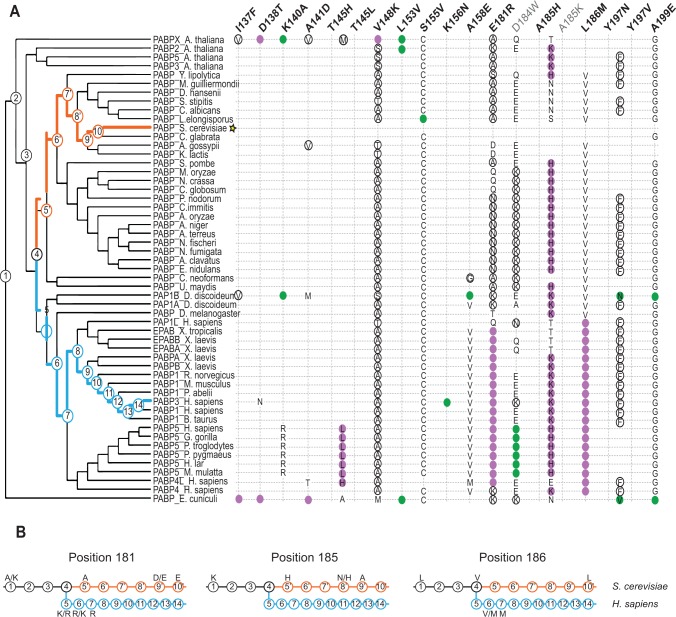
Distribution of single amino acid substitution effects across the Pab1 phylogenetic tree.A) A cladogram describing the phylogenetic lineage of 52 Pab1 homologues. The numbered nodes along the tree represent the common ancestors shared between different branches of the tree that lead to the speciation of PABP-1 orthologues in S. cerevisiae and H. sapiens. The light blue and the orange paths represent the evolutionary lineages of the human and the yeast, respectively, since the fungal and metazoan poly(A)-binding protein divergence. The position of S. cerevisiae in the tree is designated by a star. Each column represents one of the 19 single amino acid substitutions from Pab1 RRM2 homologues that were found to be deleterious. Effects by substitution names depicted in gray are less reliable due to lower input read count. The rows are the Pab1 homologues shown in the phylogenetic tree. A filled circle depicts the presence of the specified substitution in a particular sequence. Purple circles depict mutations that interfere with eIF4G binding and black circles represent mutations that had no effect on eIF4G binding. For two deleterious mutations that occur at the same position, the identities are specified within the colored circle. Also specified are the identities of other amino acids found at the same sites as the deleterious mutations that are either mildly deleterious (open black circle) or non-deleterious (all others). The absence of any marking for a given homologue indicates that the same residue is present in S. cerevisiae at that position. B) The common ancestors from the S. cerevisiae and the H. sapiens lineages shown in (A) are displayed. For each of the designated positions the most probable amino acid is shown (see Material and Methods for reconstruction probability cutoff). Two amino acids are shown with the most likely amino acid designated on the right, if both have high probability score but neither is above the reconstruction probability cutoff. Ancestral sequences with no designated amino acid share the same amino acid identity with the former ancestral sequence.